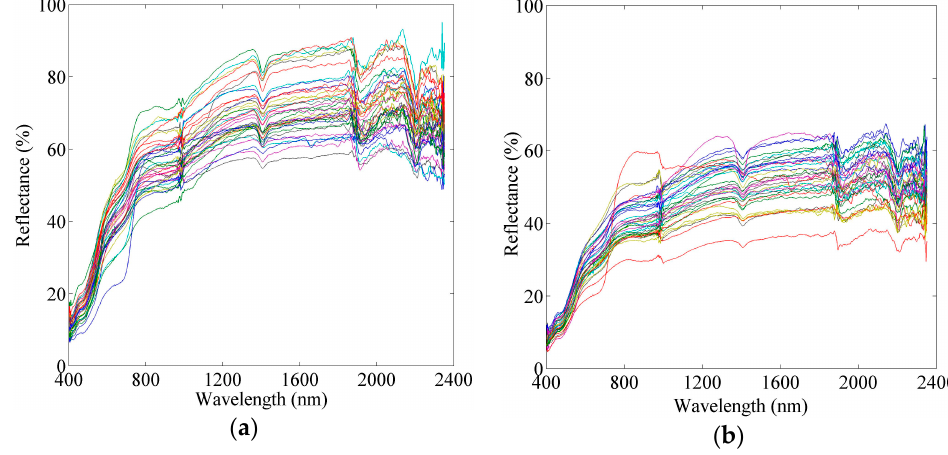
Figure 3. Result of soil reflectance spectra classification with K-means clustering based on squared Euclidean distance. ( a ) Is Group E1 and ( b ) is Group E2.